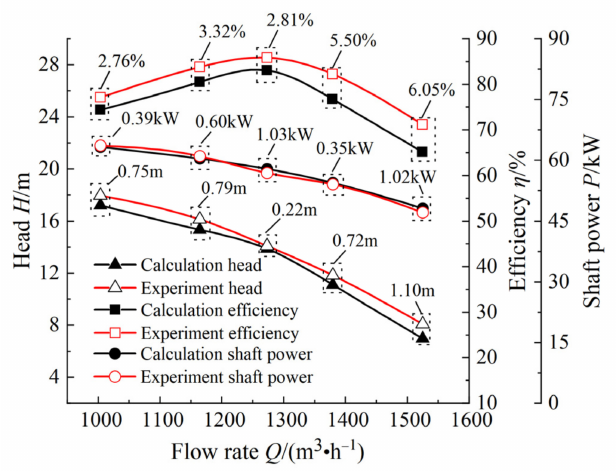
Figure 5. Comparison between numerical simulation and experimental performance